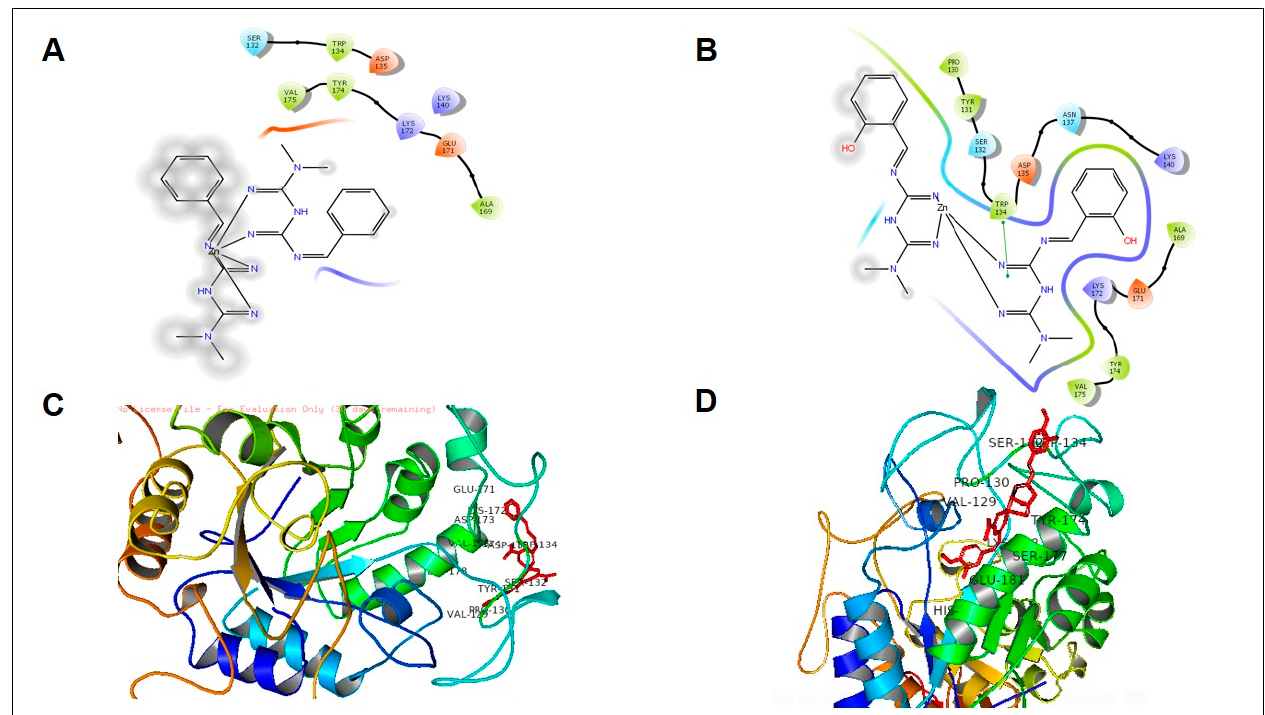
Figure 6. Induced fit docking study of the best pose generated on α -amylase: ( A ) MZn1 ligand-binding site; ( B ) MZn2 ligand-binding site; ( C ) MZn3 ligand-binding site; ( D ) MZn8 ligand-binding site.